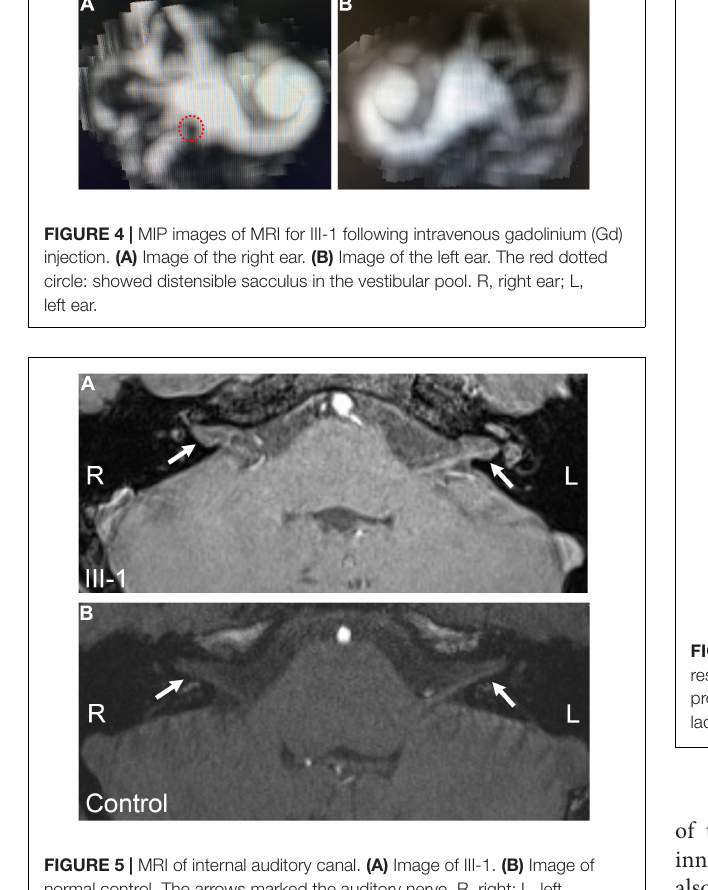
FIGURE 5 | MRI of internal auditory canal. (A) Image of III-1. (B) Image of normal control. The arrows marked the auditory nerve. R, right; L, left.